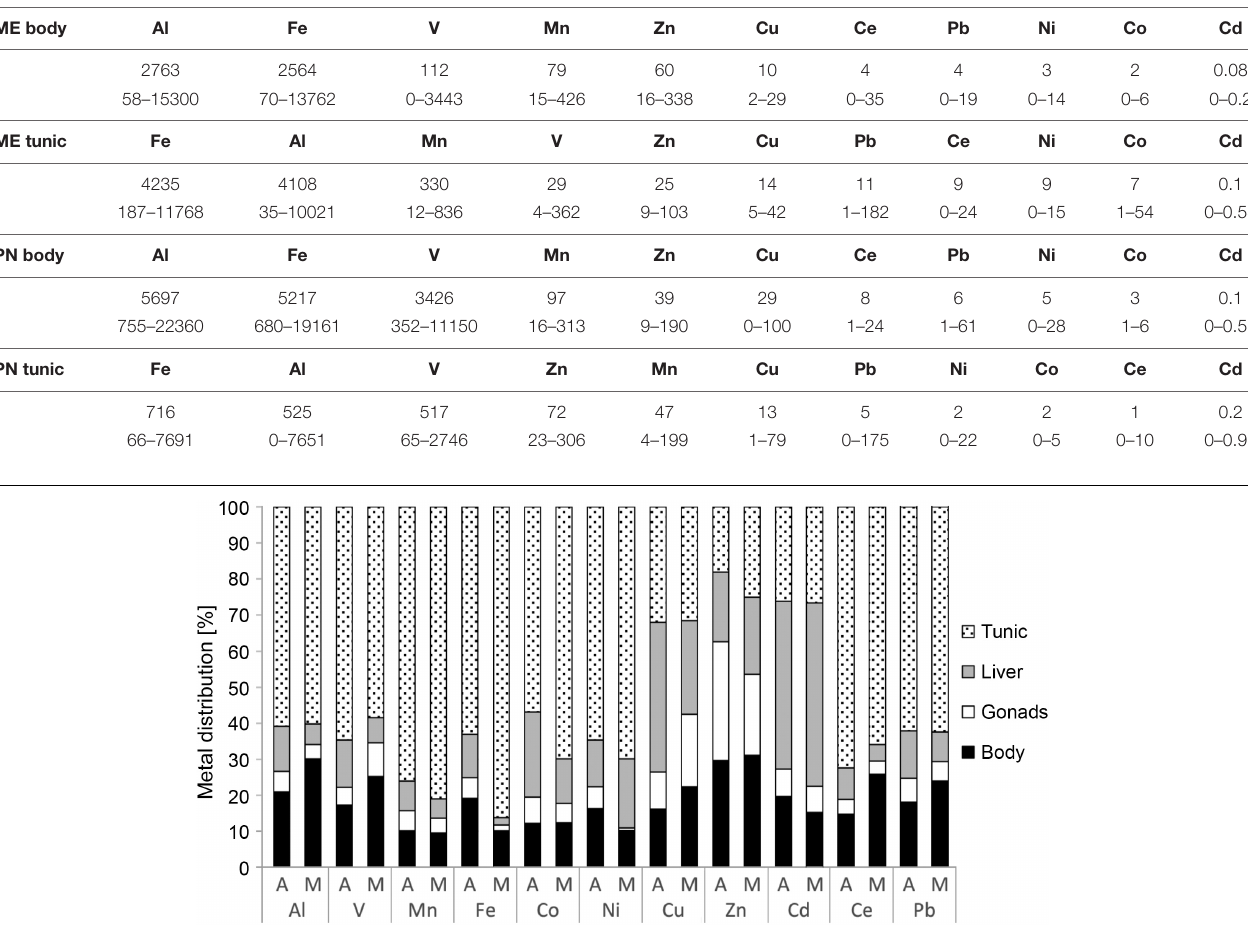
TABLE 1 | The mean metal levels ( µ g/g), and range in the body and tunic of M. exasperatus (ME body and ME tunic, n = 50) and of P. nigra (PN body, PN tunic, n = 58) measured throughout the study arranged in order of decreasing abundance (from left to right).